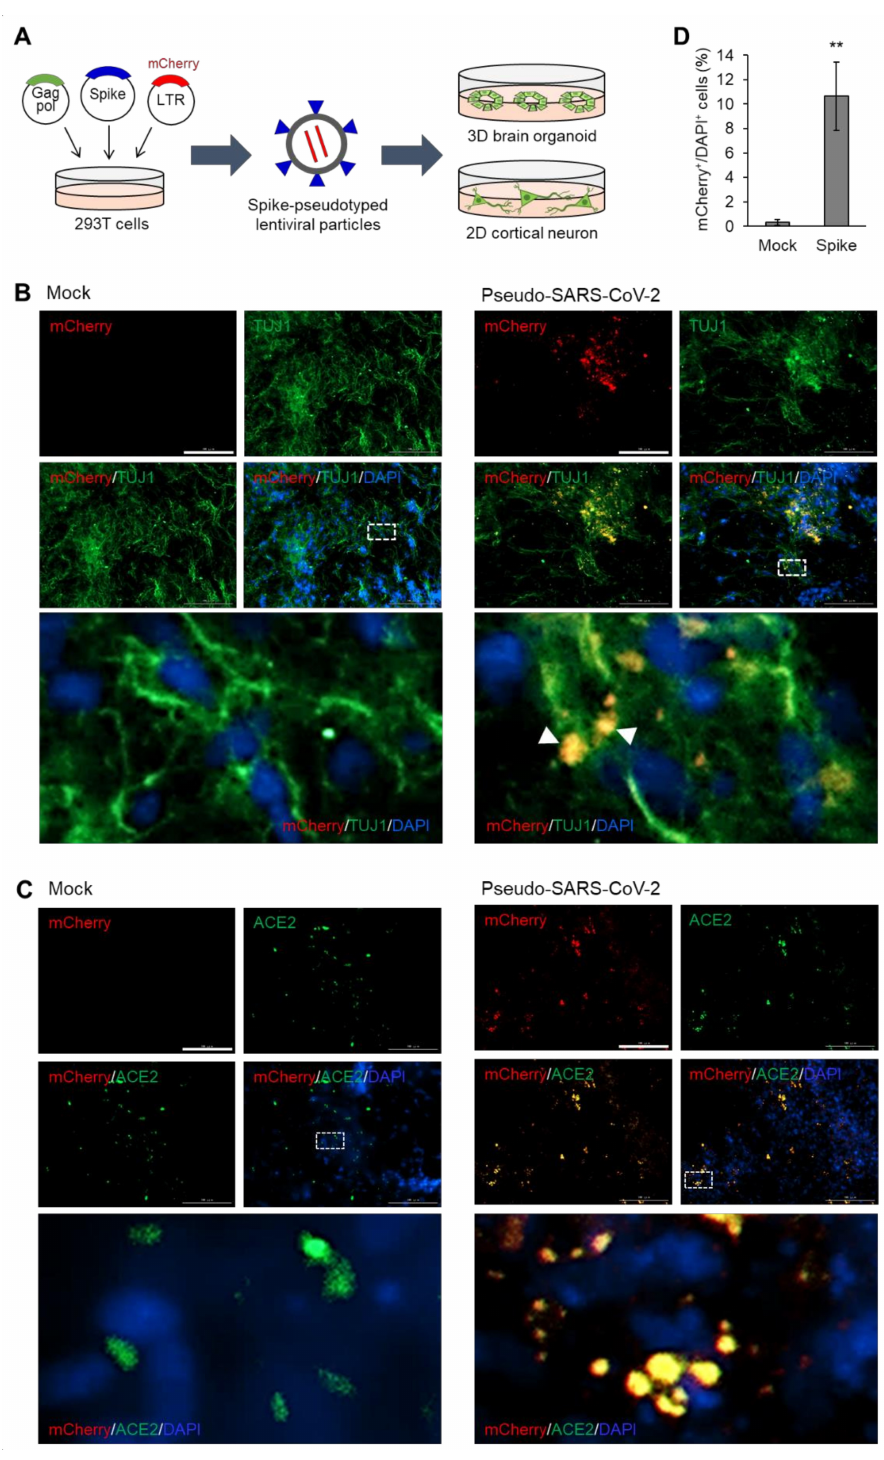
Figure 1. Infection of brain organoids with pseudotyped SARS-CoV-2. ( A ) Schematic illustration of pseudotyped SARS-CoV-2 infection of brain organoids and cortical neurons. ( B ) Immunofluorescence of mock-treated or SARS-CoV-2 pseudovirus-treated dorsal forebrain organoids (6 months) for detecting pseudotyped SARS-CoV-2 spike (mCherry) and TUJ1. ( C ) Immunofluorescence of mock-treated or SARS-CoV-2 pseudovirus-treated dorsal forebrain organoids (6 months) for detecting pseudotyped SARS-CoV-2 spike (mCherry) and ACE2. ( D ) Quantification of immunofluorescence indicates the percentage of mCherry-positive cells among the total DAPI-positive cells. In D, data are presented as mean ± SD ( n = 4). * p < 0.05; ** p < 0.01; *** p < 0.001. Scale bar, 100 µ